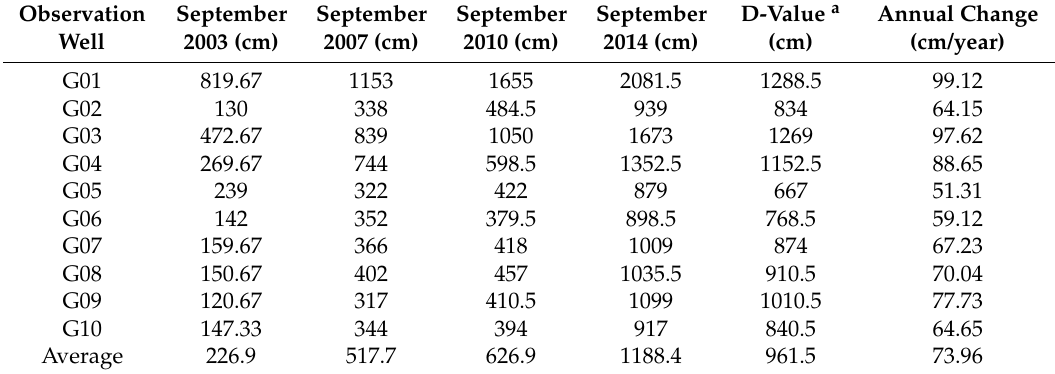
Table 4. Linear trend analysis of trend components of the ten groundwater sites recorded during the period 2002 to 2014. The four columns show the monthly change in September, during 2003, 2007, 2010, and